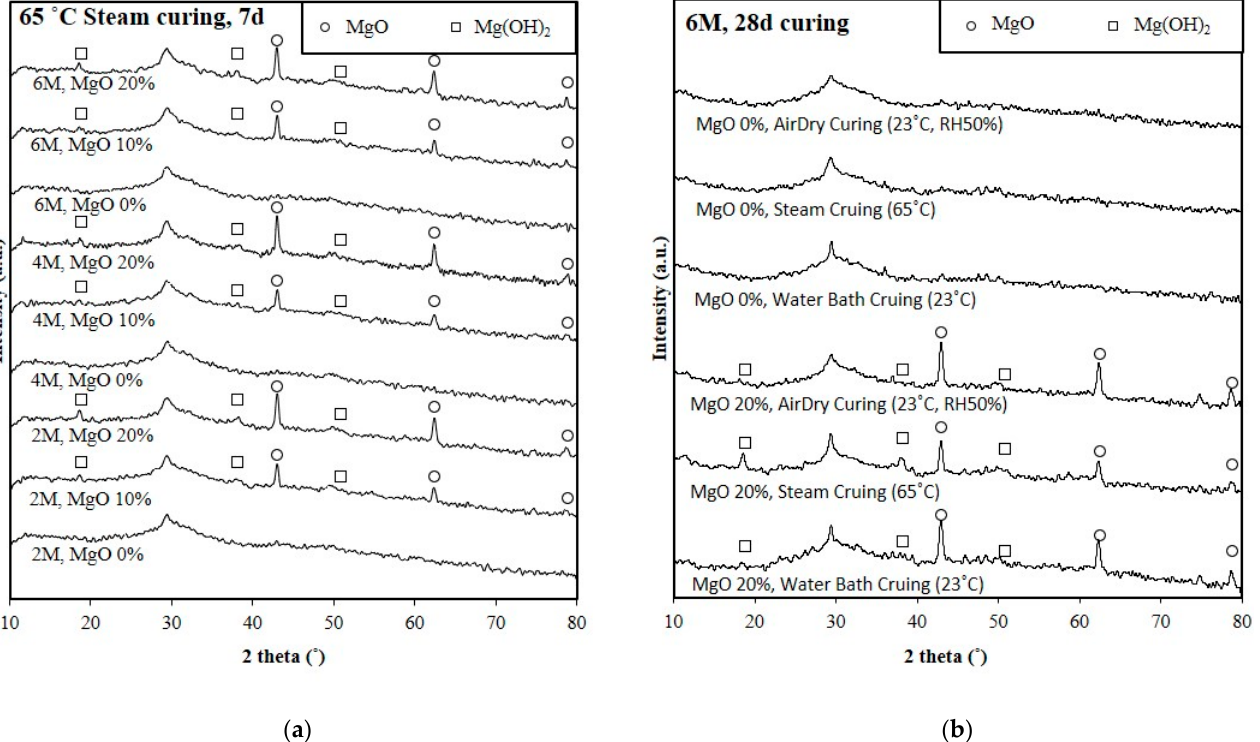
Figure 9. XRD analysis of the GGBFS-based GP specimens contains different amounts of MgO and various curing environments. ( a ) Steam curing for 7 days; ( b ) 6 M GP curing in 3 environments for 28 days.